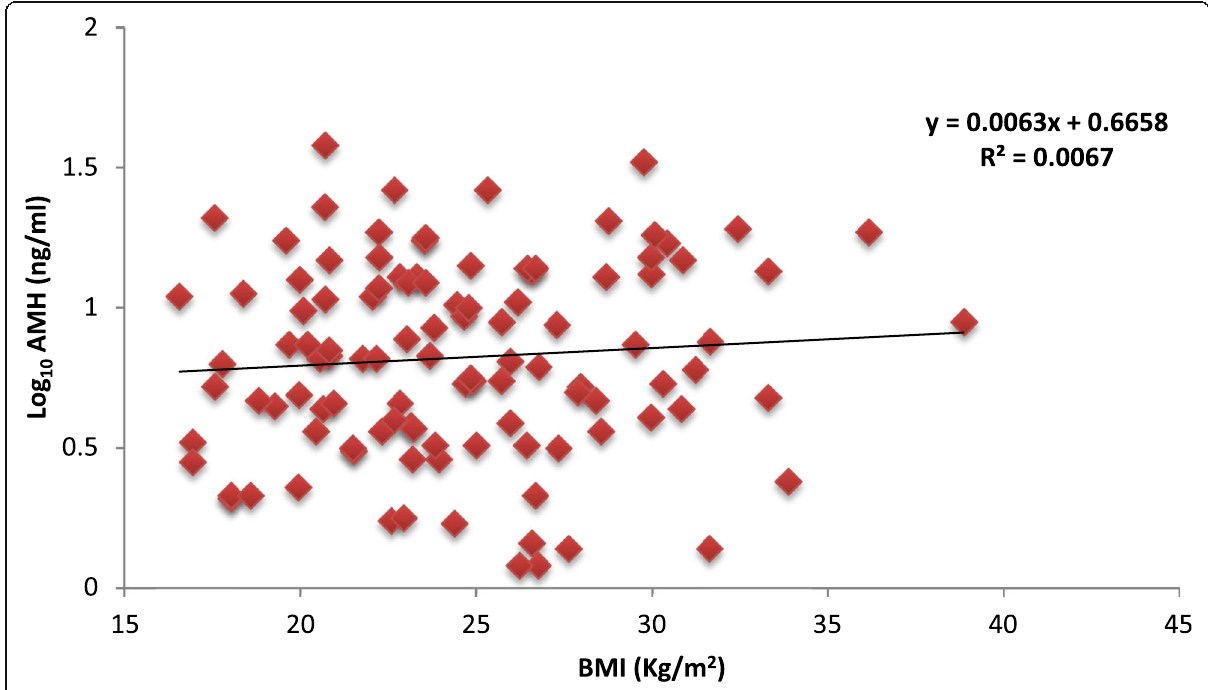
Fig. 4 Scatterplot of Log 10 AMH (ng/mL) by BMI in kg/m 2 in Fertile women